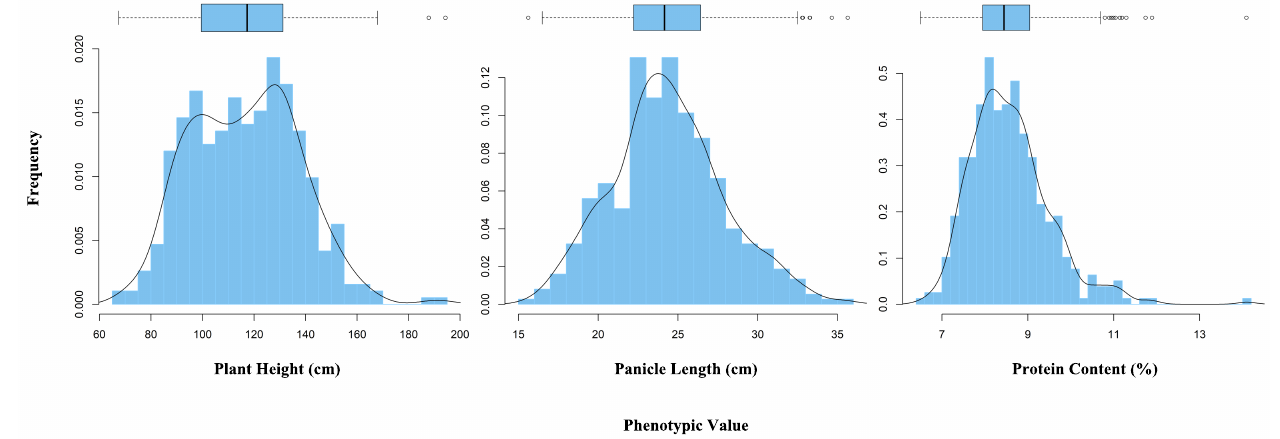
Figure 1. Descriptive statistics of phenotypic values for the three yield-related traits (PH, PL, and